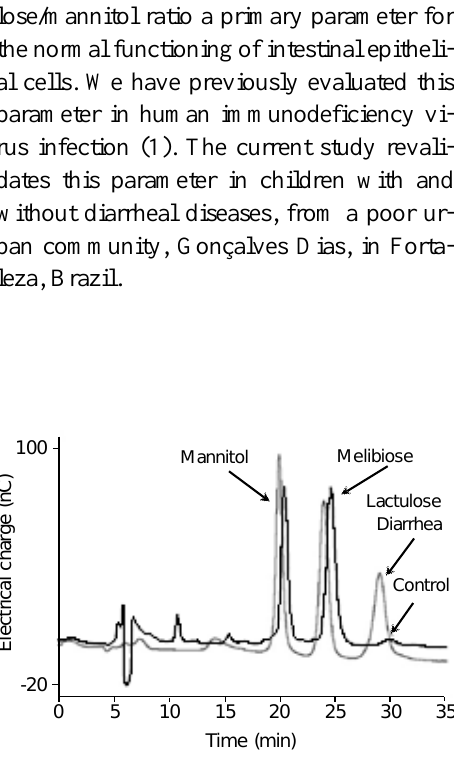
Figure 1 - Detection of lactulose and mannitol in urine of children with and without diarrhea. The figure shows two chromatograms of the lactulose and mannitol peaks for children with and without diarrheal disease. The mannitol peak showed no significant difference between children with diarrhea and healthy children. In contrast, children with diarrhea had a higher peak for lactulose compared to children without diarrhea, sug- gesting a change in intestinal permeability or mucosal damage. Melibiose peaks in both chromatograms are used as control internal standards for the quantification of the sugars.